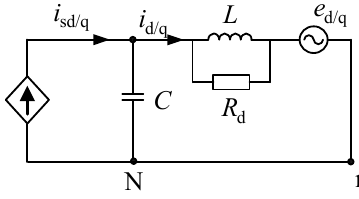
Figure 3. Traditional passive damping.